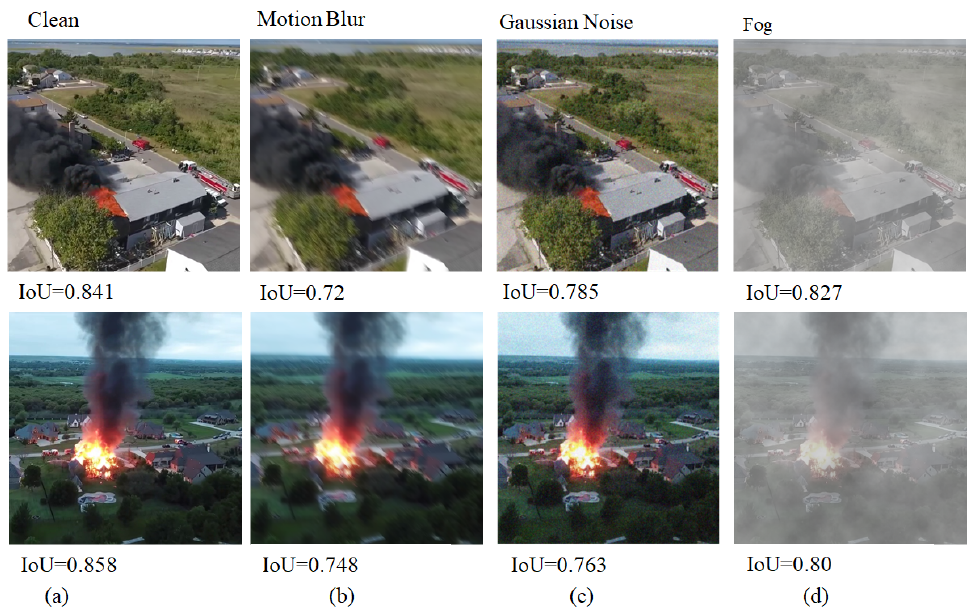
Figure 9. Samples of robustness evaluation, which consisted of ( a ) normal, ( b ) motion blur, ( c ) Gaus- sian noise, and ( d )